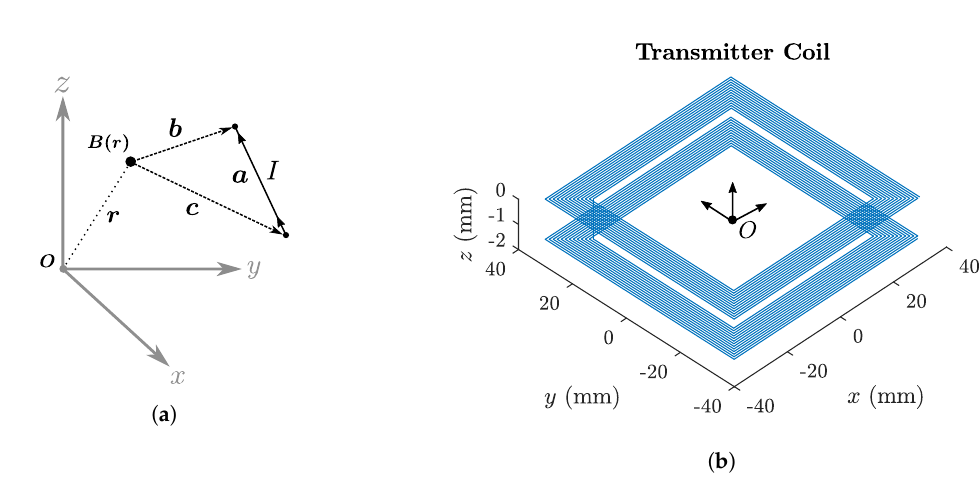
Figure 4. ( a ) Vector diagram showing the vectors in Equation (8). a is a vector representing the length and direction of a current carrying conductive filament. r is the vector from the origin to the observation point from which the field due to the filament is measured. Vectors c and b point from the observer position r to the start and end points of the current filament respectively. ( b ) 3D model of the double-sided PCB traces of a single transmitter coil with the origin O located at its centre. Each straight-line trace can be considered a single current